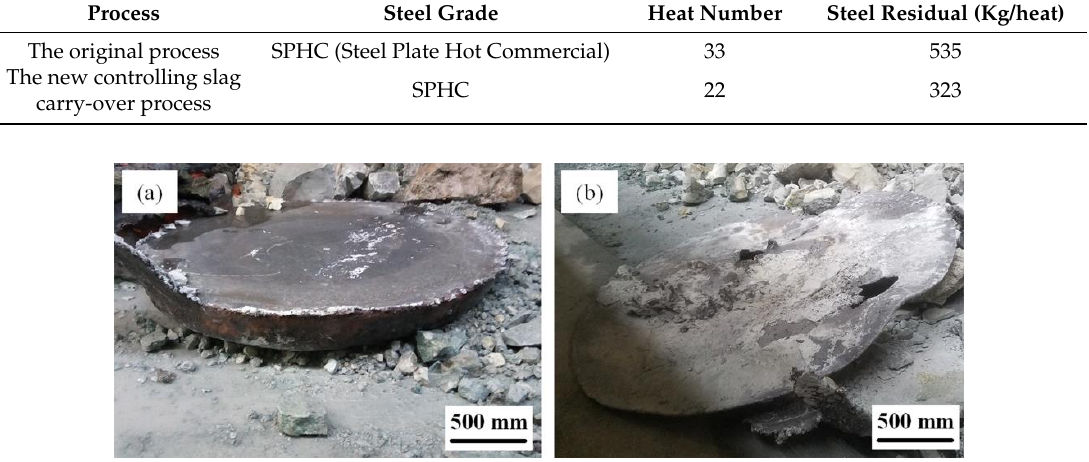
Figure 9. The typical steel residual of one heat in the ladle just finished the casting: ( a ) the original process; and ( b ) the new controlling slag carry-over process.